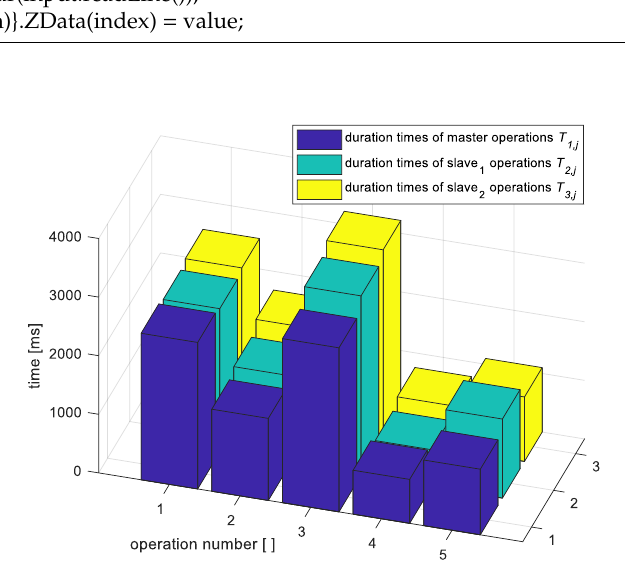
Figure 18. Visualization of operation duration in the production process.